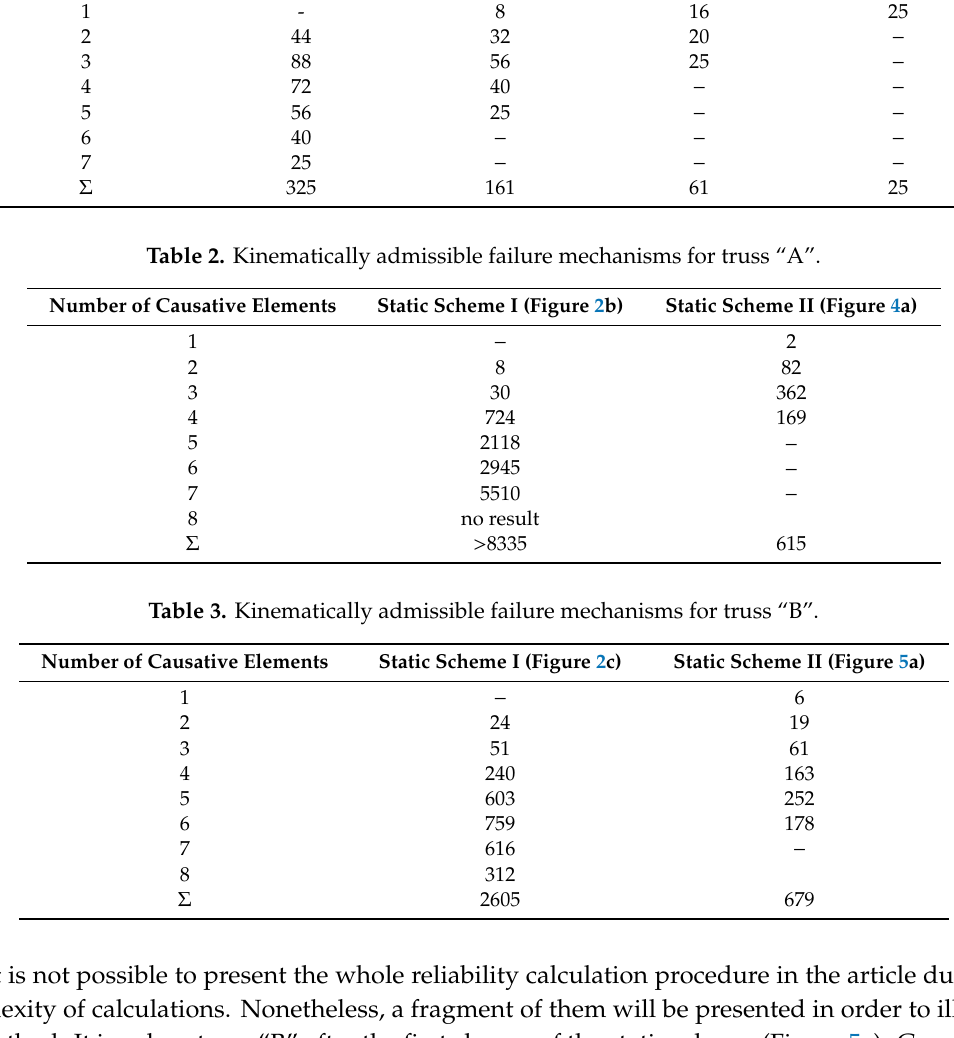
Table 1. Kinematically admissible failure mechanisms for truss “0” [26].